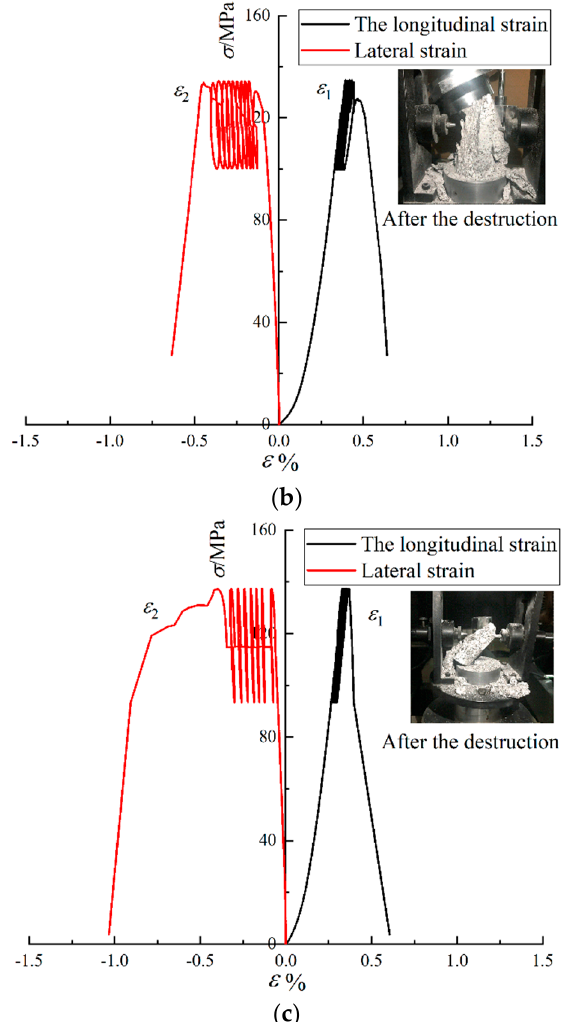
Figure 7. Stress–strain curves under 80% of the UCS: ( a ) Gra80% − 1; ( b ) Gra80% − 2; ( c ) Gra80% − 3.